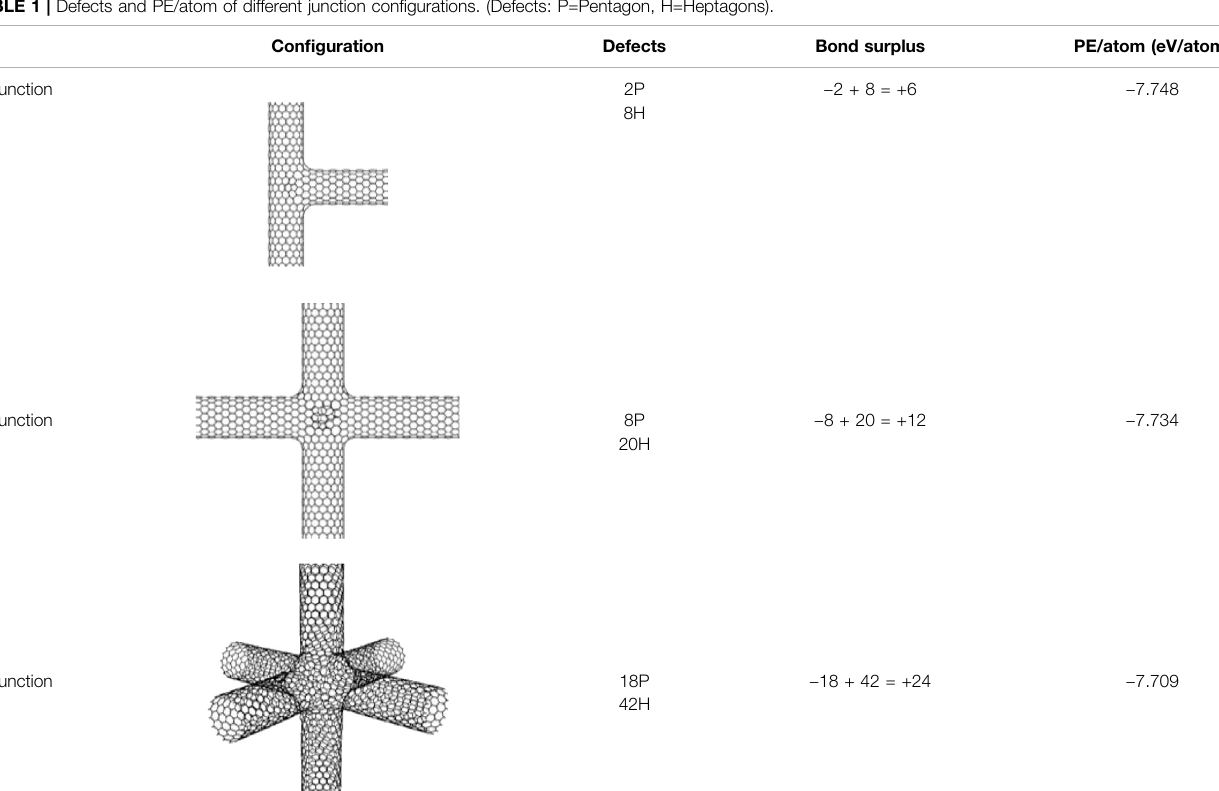
TABLE 1 | Defects and PE/atom of different junction con fi gurations. (Defects: P (cid:2) Pentagon, H (cid:2) Heptagons).